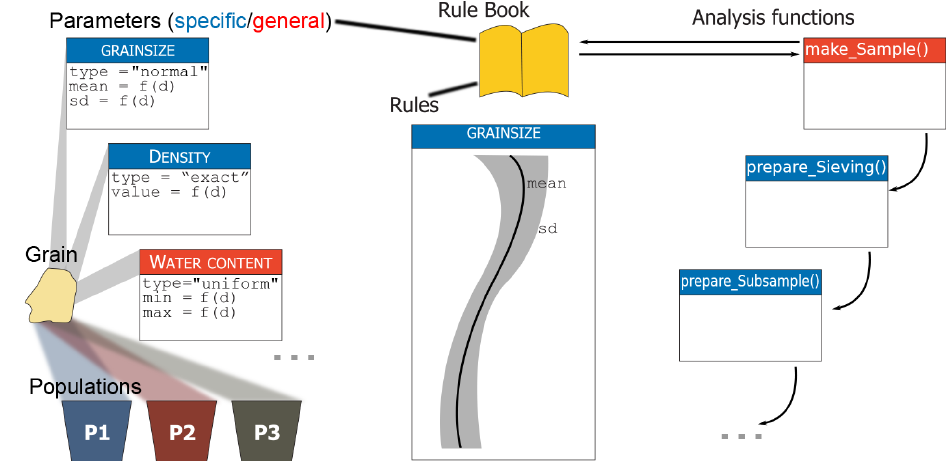
Figure 1. Concept of the model sandbox. Grains are the atomic elements of the model. They are drawn from populations and assigned parameters, which in turn are controlled by rules. Both rules and parameters are stored in rule books that act as coherent reference objects. Preparation functions are used to virtually process samples that are generated based on rule